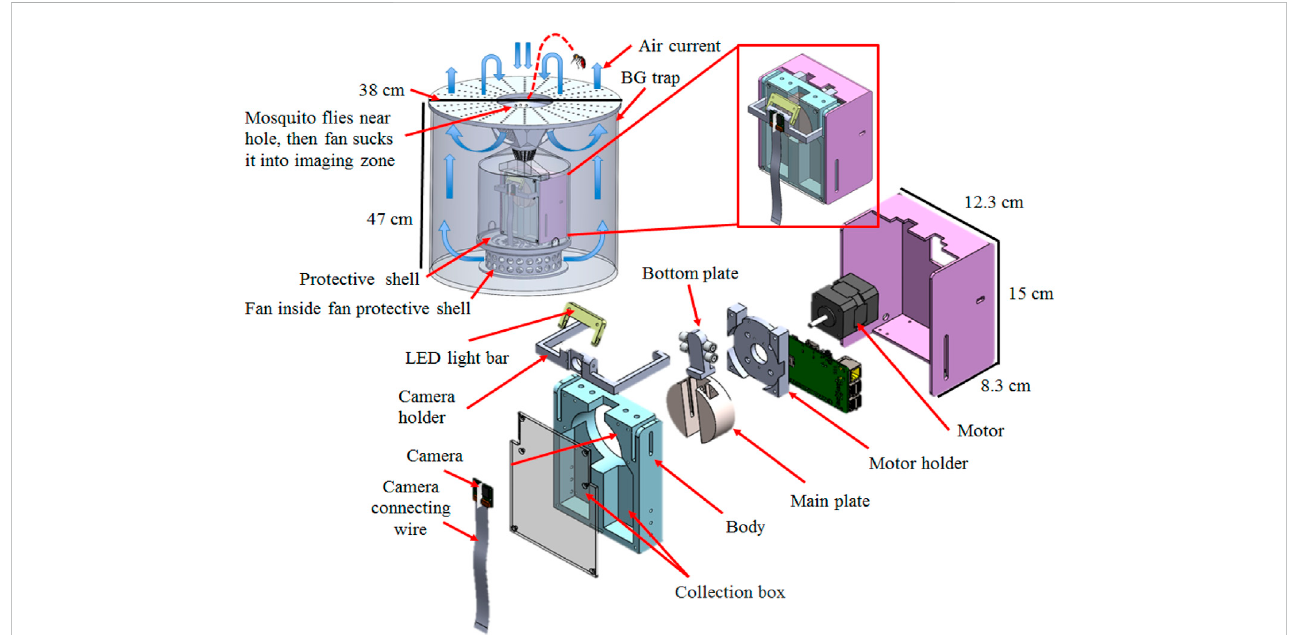
FIGURE 1 Schematic diagram of the developed mosquito trap. The large fan at the bottom of the BG trap pushes the air upward, and the three fans at the upper entrance pull the air. The air exits through the outer edge of the 38-cm-diameter lid and enters through the center. Therefore, when mosquitoes fl y near the BG trap, they are sucked in by the trap ’ s air fl ow. The core device mechanism and operating process of the mosquito trap are described in the Materials and Methods section. The mosquito trap includes two compartments (collection boxes): one on the left for collecting Aedes mosquitoes; and one on the right for collecting Culex (non- Aedes ) mosquitoes.